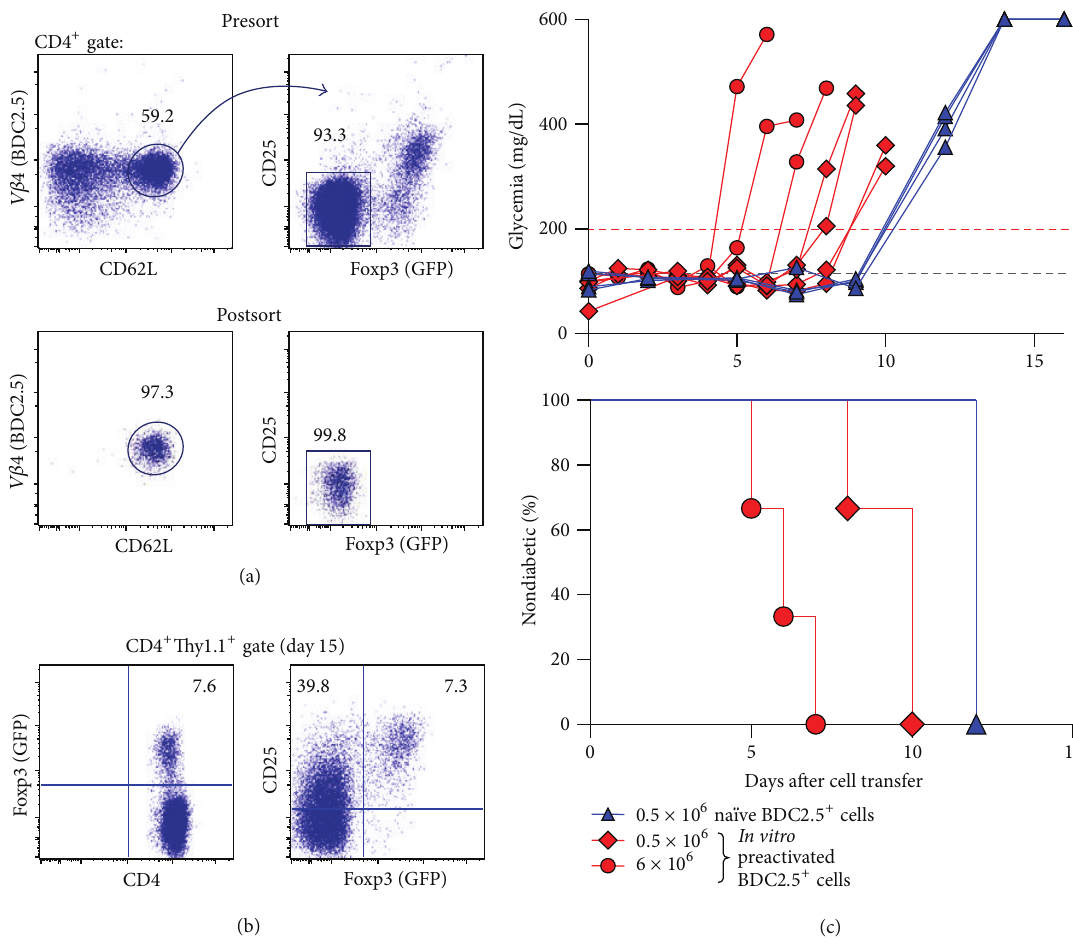
Figure 2: Adoptive BDC2.5 + T cell transfer into immunodeficient NOD mice. (a) Using anti-V 𝛽 4 antibodies, na¨ıve BDC2.5 + T cells ( CD 4 + V 𝛽4 + CD 62 L high CD25 − GFP − ) were FACS purified from NOD.Foxp 3 DTR-GFP × BDC2.5 mice, after CD4 bead enrichment of pooled cells from spleen and LNs. Presort (top) and postsort (bottom) analyses of V 𝛽 4/CD62L (left) and CD25/GFP (right) expression among CD4-gated cells are depicted. The gating scheme is illustrated by the line with arrowhead. For antigen-specific stimulation in vitro , BDC2.5 + T cells were cultured as previously described [7], in the presence of the mimotope peptide RTRPLWVRME (10 𝜇 g/mL). Na¨ıve or in vitro preactivated BDC2.5 + T cells were injected i.v. into NOD.Rag1 −/− recipient mice, as indicated below. (b) Flow cytometry of GFP (left) and CD25/GFP (right) expression among gated CD4 + cells from LNs at day 15 after adoptive transfer into NOD.Rag1 −/− recipient mice. Numbers in dot plots indicate the percentage of cells in the respective quadrant or gate. (c) Blood glucose concentrations (top) and diabetes incidence (bottom) of NOD.Rag1 −/− recipient mice injected with na¨ıve (5 × 10 5 cells/mouse, blue triangles, 𝑛 = 4 ) or in vitro preactivated BDC2.5 + T cells (5 × 10 5 cells/mouse, red squares, 𝑛 = 4 ; or 6 × 10 6 cells/mouse, red circles, 𝑛 = 3 ). Blood glucose concentrations of recipient mice were determined and plotted as described in the legend for Figure